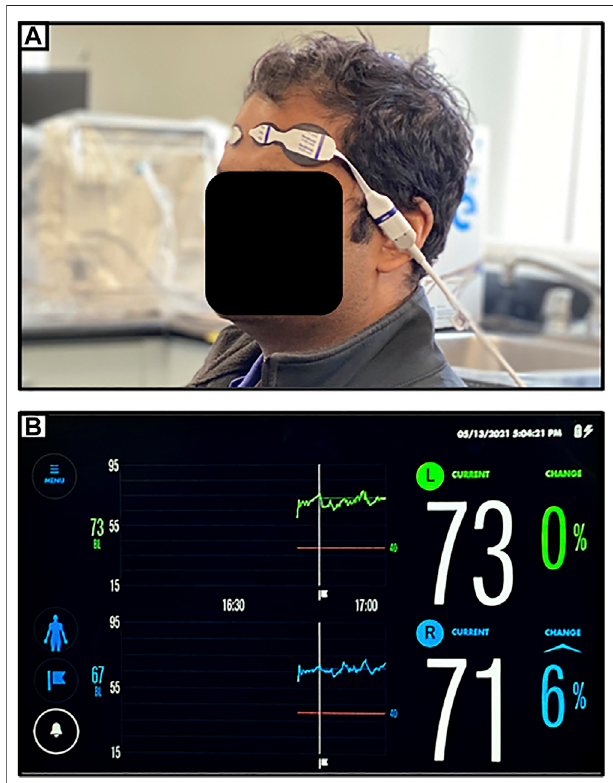
FIGURE 1 | (A) Setup for near-infrared spectroscopic (NIRS) monitoring of bilateral frontal cerebral oxygenation (as demonstrated on fi rst author). (B) Typical device readout of regional cerebral oxygen saturation (rSO 2 ) from NIRS monitoring of bilateral frontal cerebral